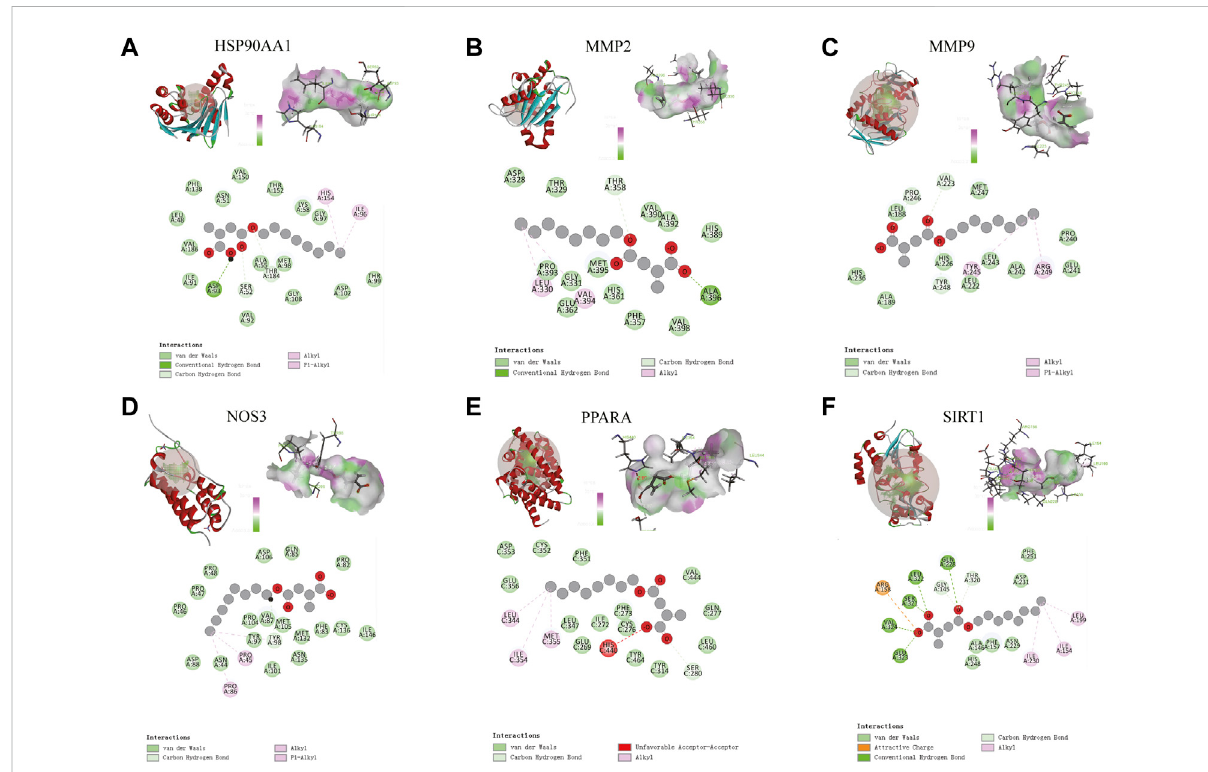
FIGURE 12 (A – F) MoleculardockingresultsofMMP9,MMP2,SIRT1,PPARA, NOS3,andHSP90AA1with4-OI.(Upperleft)4-OIdockingmodelwiththehub target. (Top right) In the interaction diagram of 4-OI and the hub target hydrogen bond residues, the greener the color, the stronger the interaction force,andthemorepurplethecolor,theweakertheinteractionforce.(Bottom)Variousinteractionsof4-OIwithhubtargets,eachcolorinthecircle corresponds to a mode of